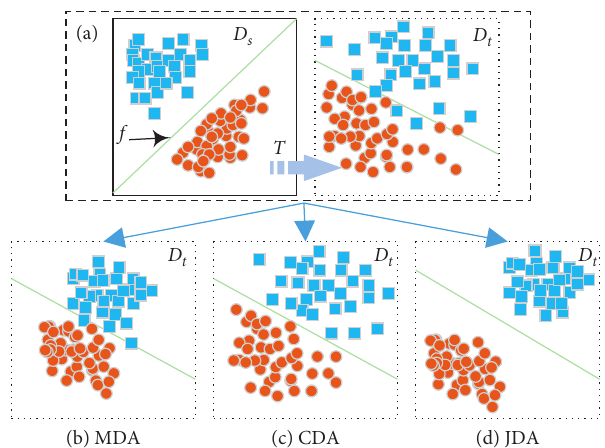
Figure 1: An illustration of the crossdomain learning process by using MDA, CDA, and